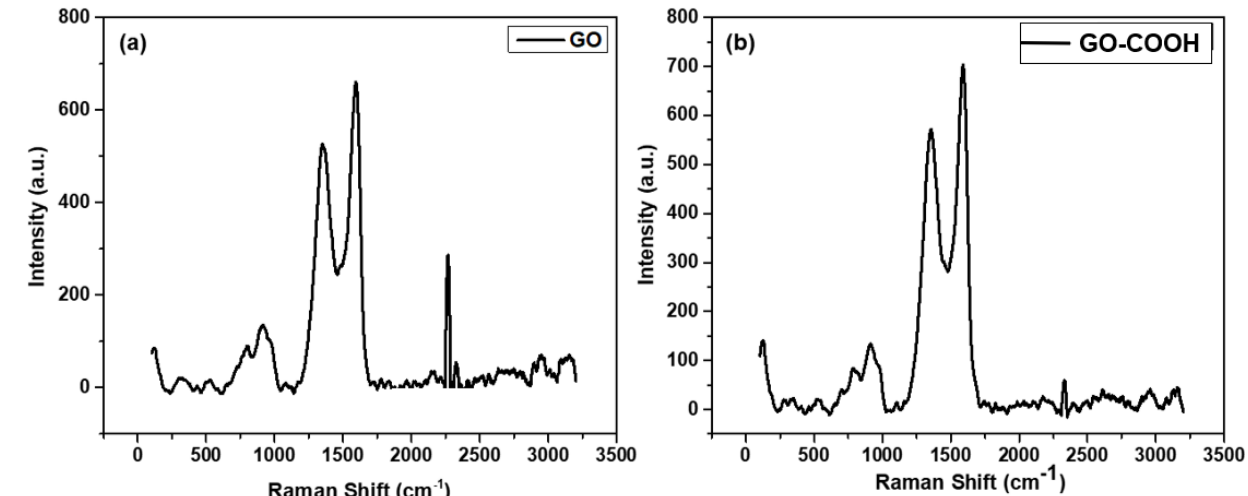
Figure 3. ( a ) Raman spectra of GO, ( b ) Raman spectra of GO-COOH.